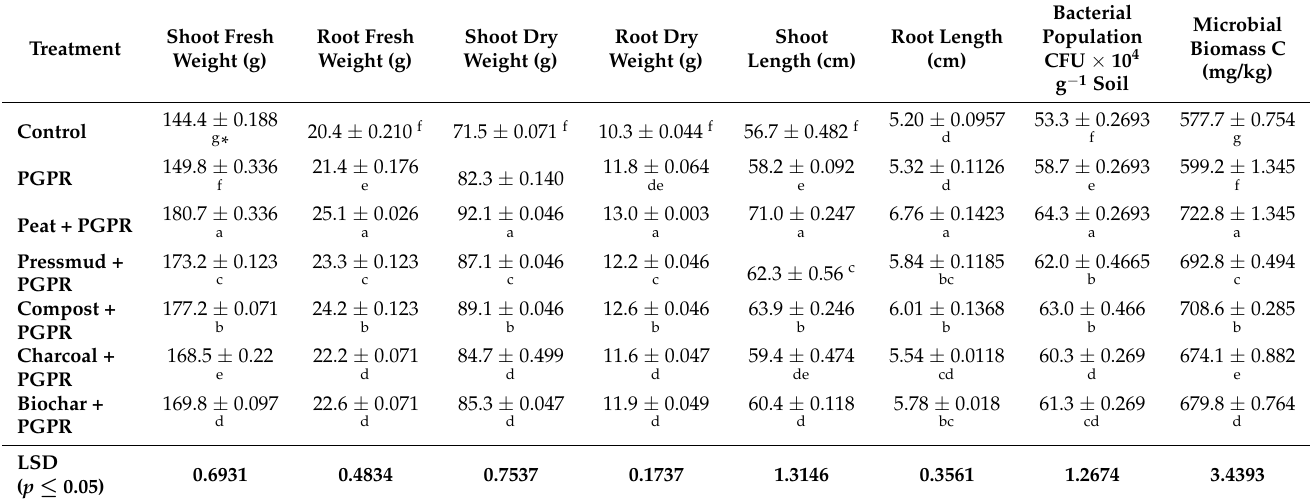
Table 2. Effect of different carrier materials on physiological parameters of okra in pot